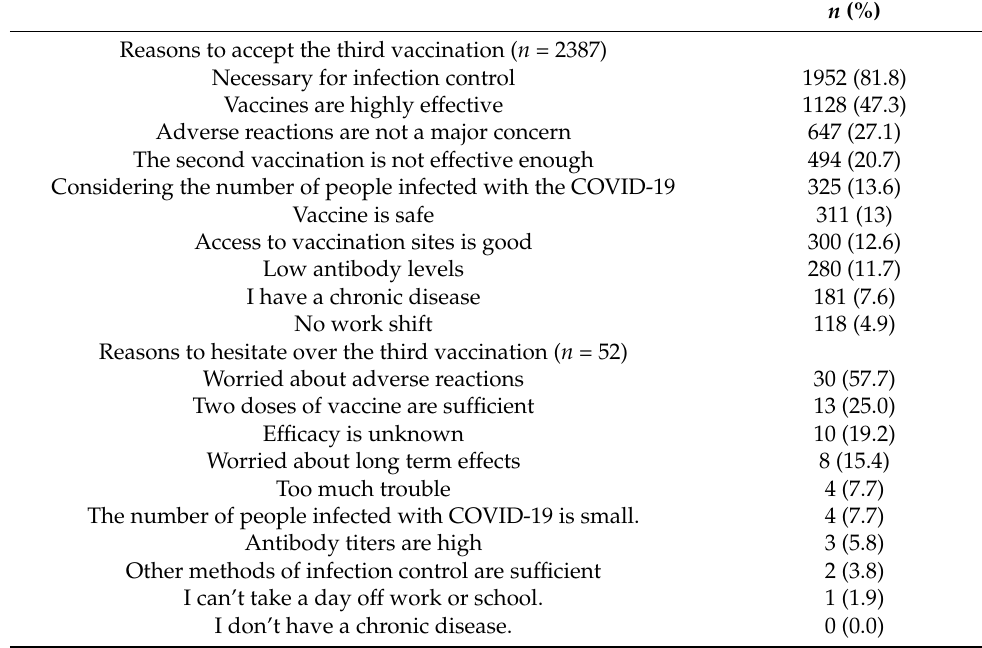
Table 2. Reasons to accept or hesitate over a third COVID-19 vaccine dose ( n =